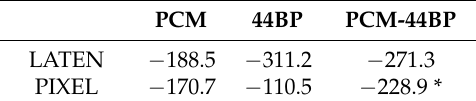
Table 4. Table of lattice energies for ( 1 ), ( 2 ) and ( 3 ) predicted by the LATEN option in the XD package and the PIXEL program developed by Gavezzotti. Energies are given in kJ · mol − 1